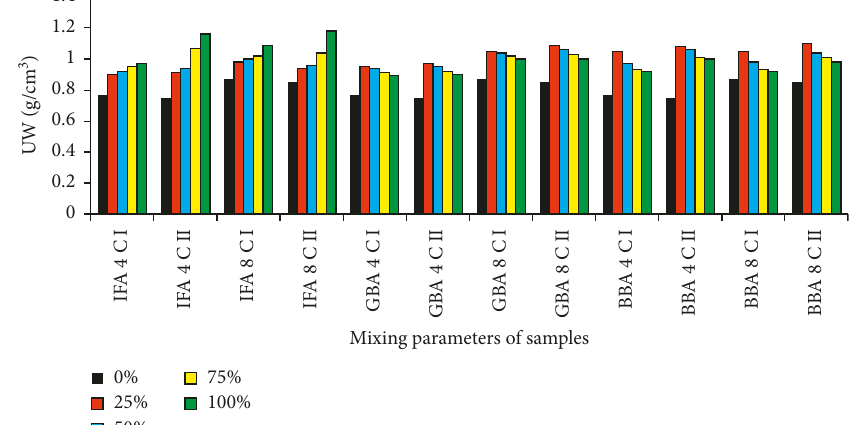
Figure 6: Relationship of UW of the samples having different admixtures. IFA: ˙Isken FA; 4: BC40; 8: BC80; C: CEM; GBA: G¨oknur BA; BBA: Bor BA.